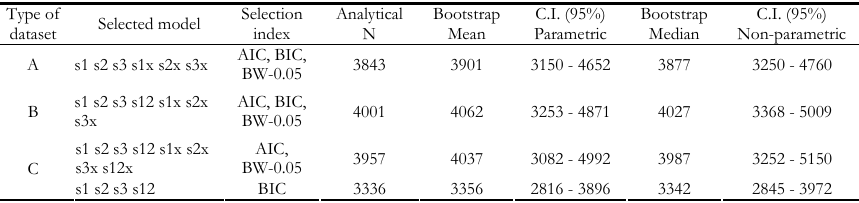
Estimated population size (N), Bootstrap Mean, Median and 95%